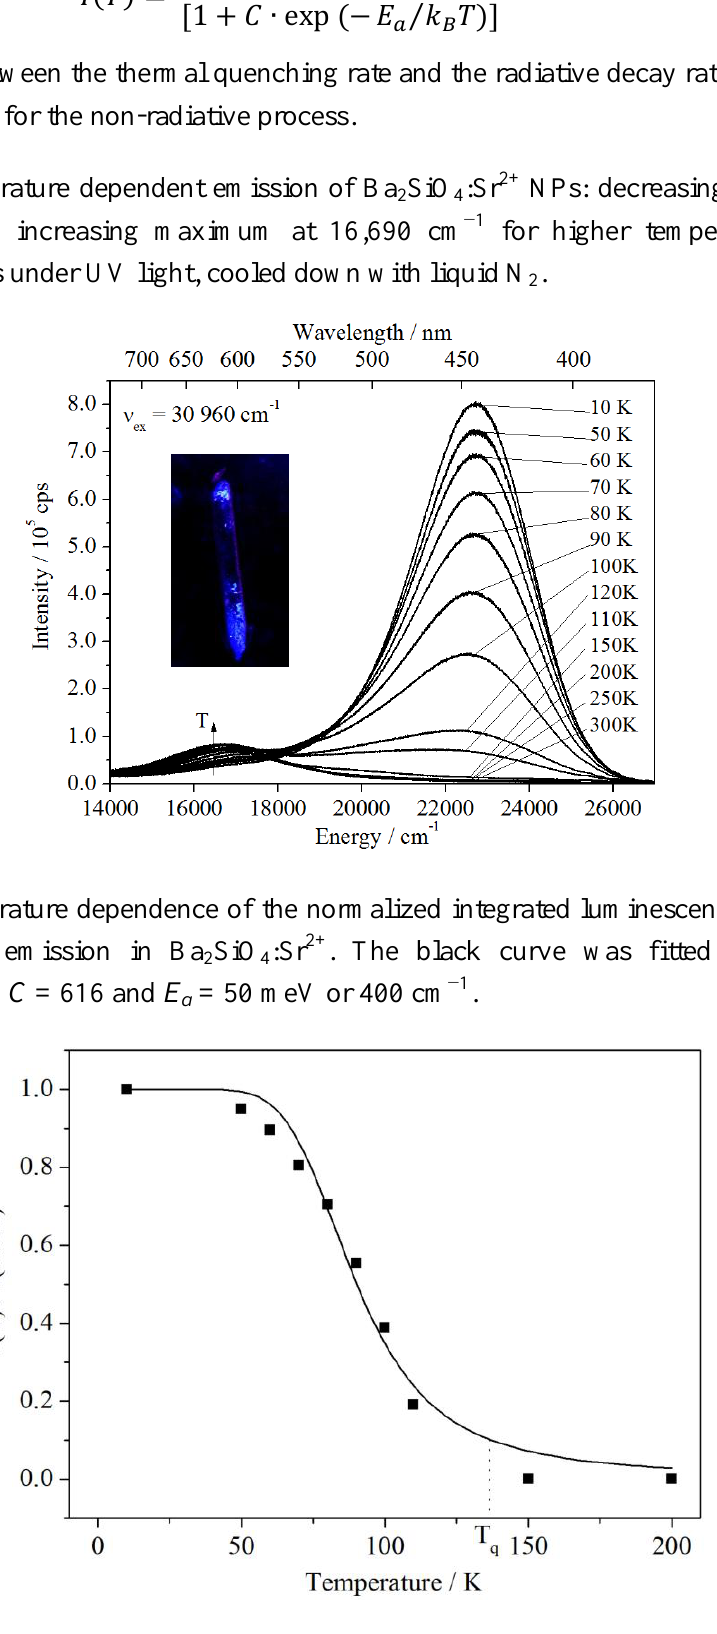
SiO :Sr 2+ NPs: decreasing maximum at 2 4 . 2